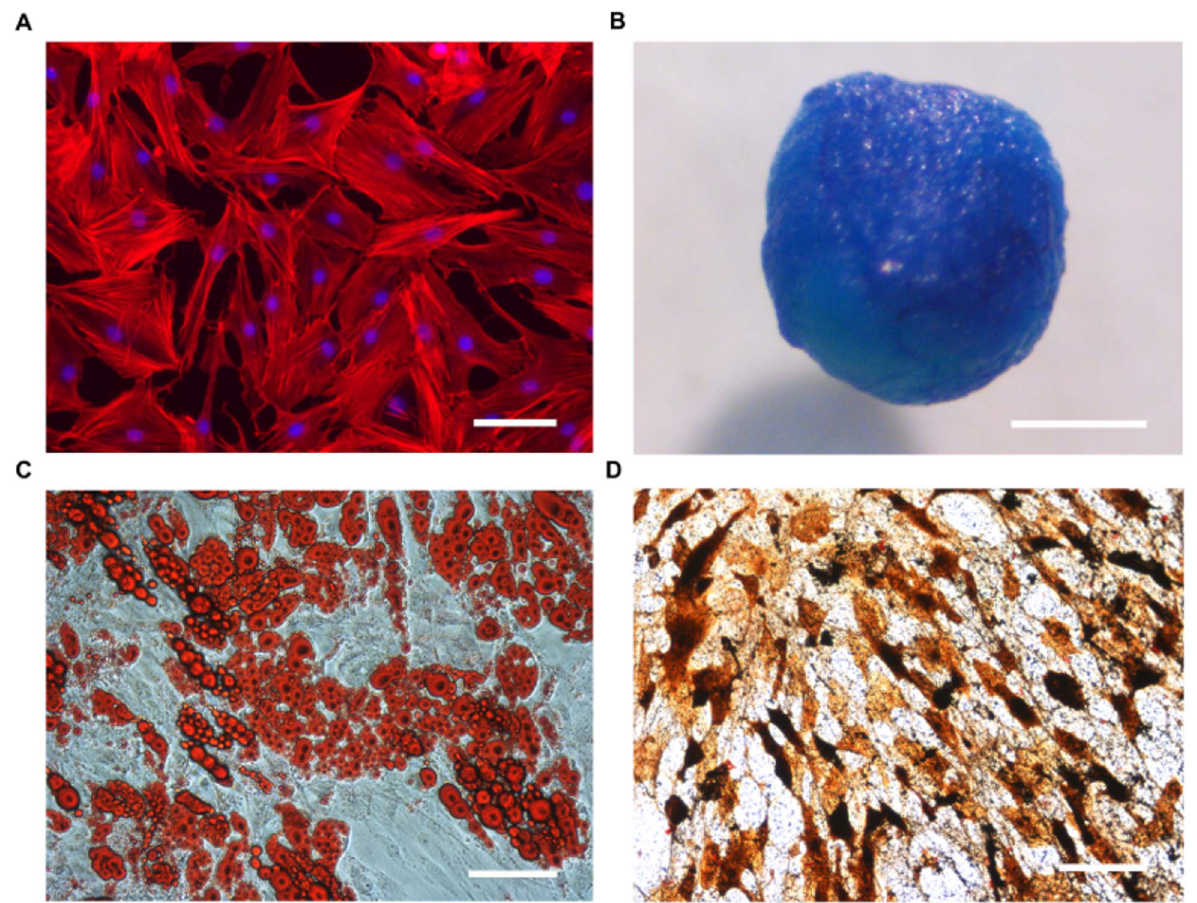
Figure 1. Cell characterization. After isolation, cells adhered to tissue culture plastic showing a fibroblast-like morphology (A, DAPI (blue)/ phalloidin (red) staining) and multipotency (B–D). Chondrogenic (B), adipogenic (C) and osteogenic (D) differentiation potential was confirmed by Alcian blue, Oil red O and von Kossa staining, respectively. Scale bars represent 100 m m in A, C, D and 1 mm in B.